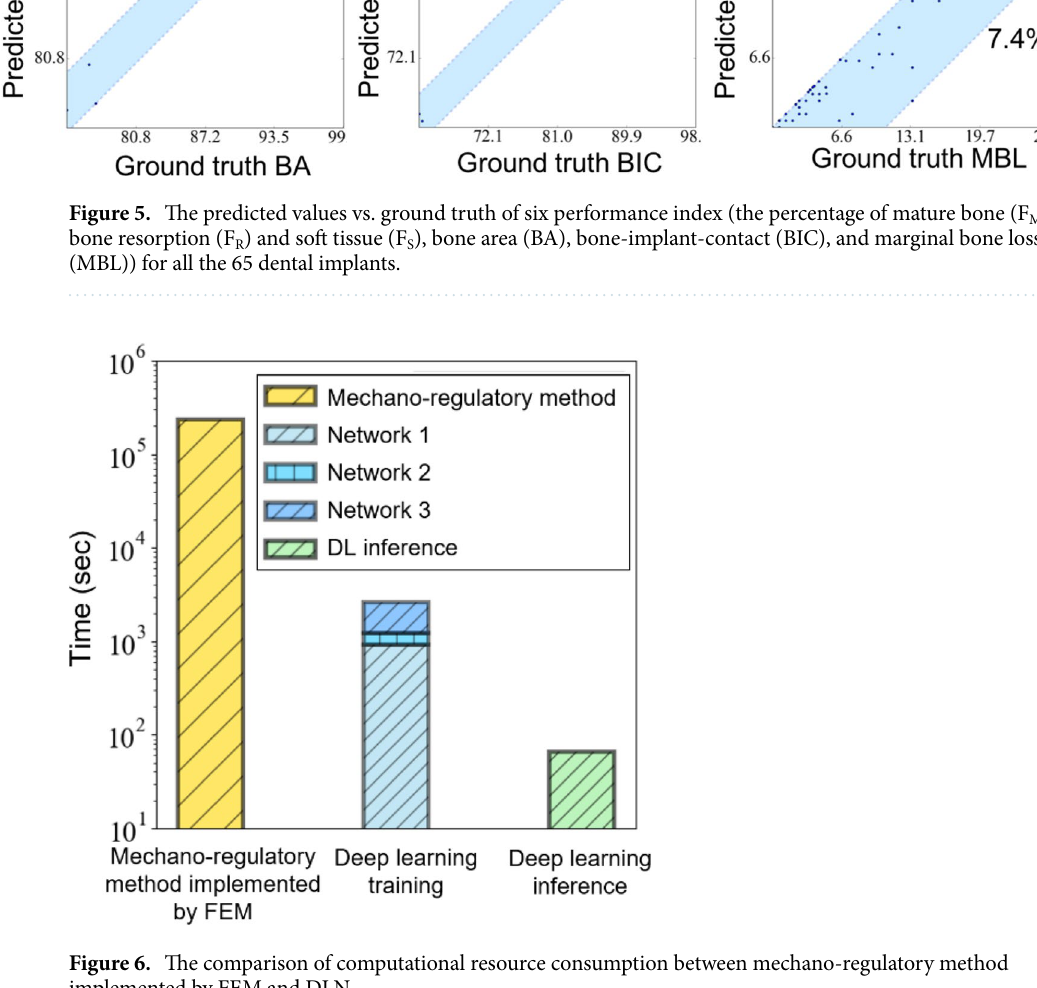
pixels throughout 35 days in the 14 implants used in Figs. 2 and 3. The regions separated by black lines in Fig. 7 represent the five tissue phenotypes. The color of each data point indicates the most important physical proper-